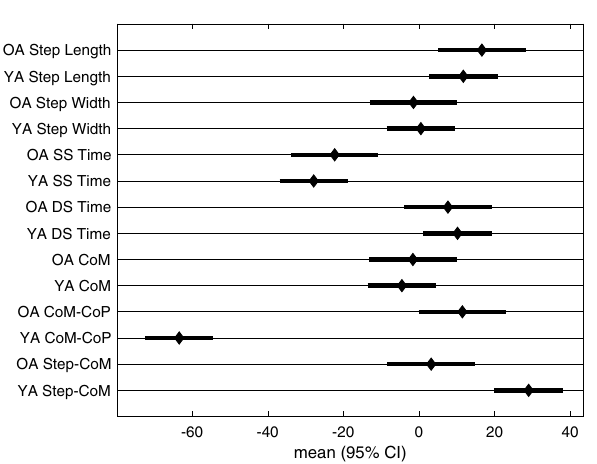
Figure 6. Split Magnitude of Plateau posthoc comparison figure: estimated 95% confidence intervals for % (cid:31) magnitude of the plateau during the split condition [lmer Eq. (2)]. Confidence intervals that do not overlap reflects a significant difference between